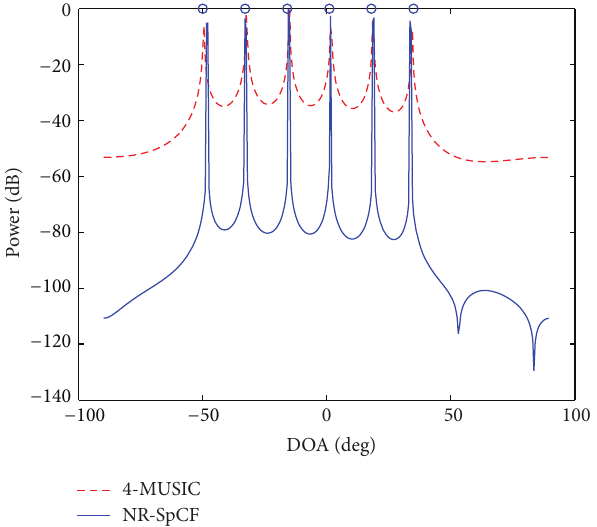
Figure 4: RMSE versus SNR for the six methods in spatially correlated noise case. 𝑀 = 6 , 𝑄 = 2 , and 𝑇 = 1000 .